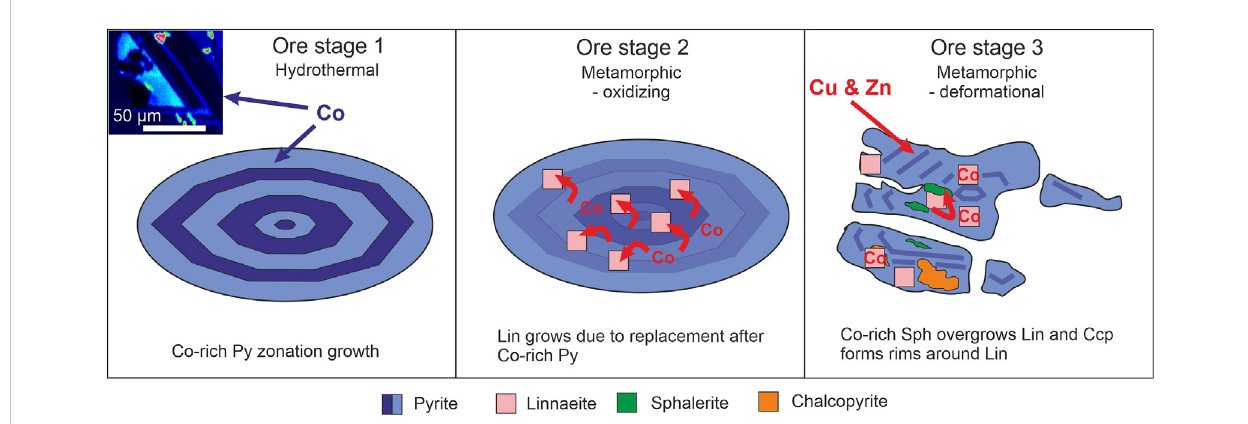
FIGURE 9 SchematicreconstructionofComobilizationandredistributionbetweensul fi desduringthemainCo(-Cu-Zn)DOFmineralization(OreStages1 – 3), based on the polysul fi de cluster mineralization of this study. The hydrothermal Ore Stage one introduced the majority of the Co in pyrite (indicated by blue shades in the fi gure), as seen in the inset EPMA Co map. Ore Stage two is de fi ned by a change in redox state of the mineralizing system to more oxidizedconditions, resultinginpyrite-hosted Co 2+ tooxidizetoCo 3+ ,andleadingtotheformationoflinnaeite.ThebrittledeformationalOreStage 3 saw redox states returning to Co 2+ , which enabled the incorporation of Co in newly formed sphalerite. Schematic is based on the DOF